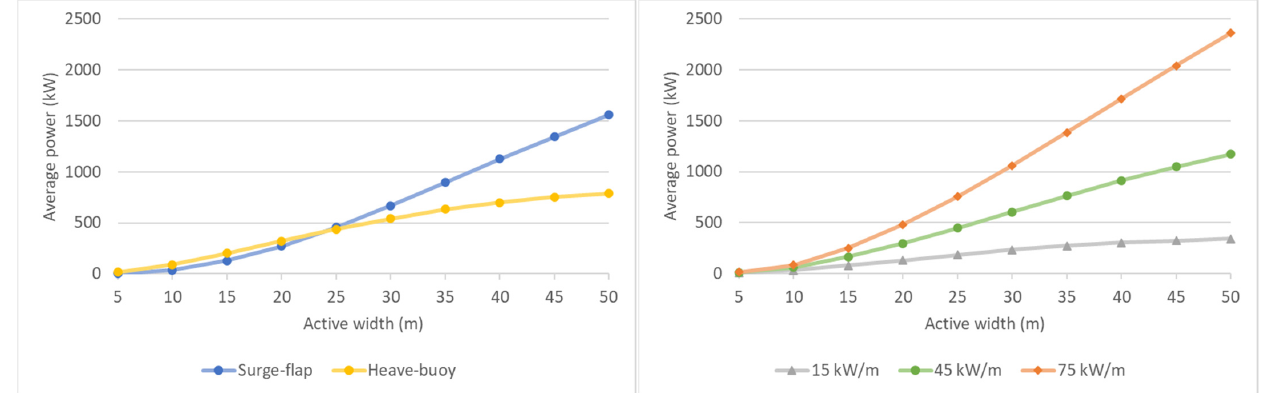
Figure 5. Fundamental relationship between SOTA mean power and the scale for (left-hand graph) surge-flap and heave- buoy type WECs at 45 kW/m and (right-hand graph) for an average of the two WEC types at 15, 45 and 75 kW/m resource levels. The right-hand graph shows the relationships used in the tool as the SOTA thresholds.